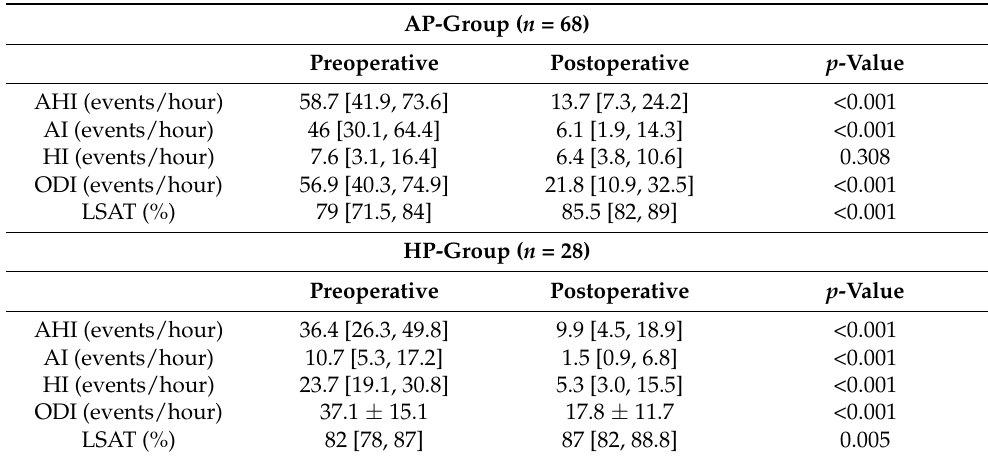
Table 3. Preoperative and postoperative polysomnography values in AP-group and